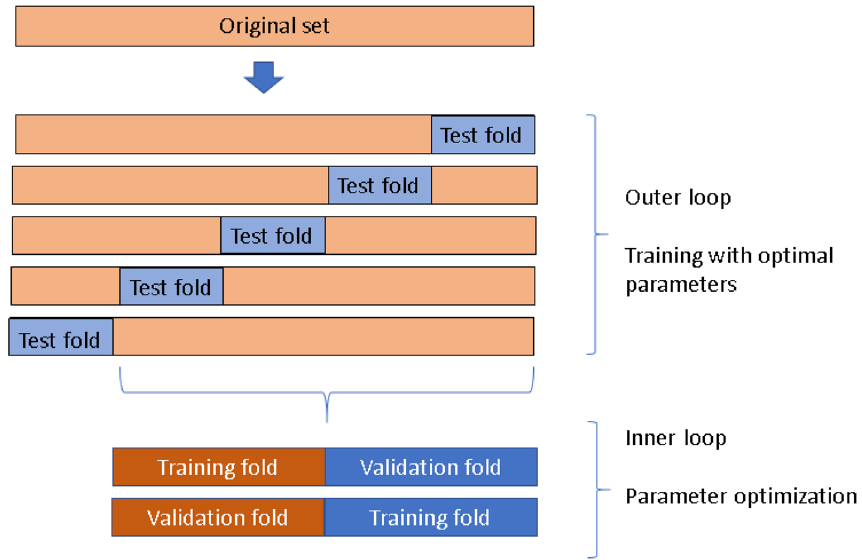
Figure 5. A nested cross validation